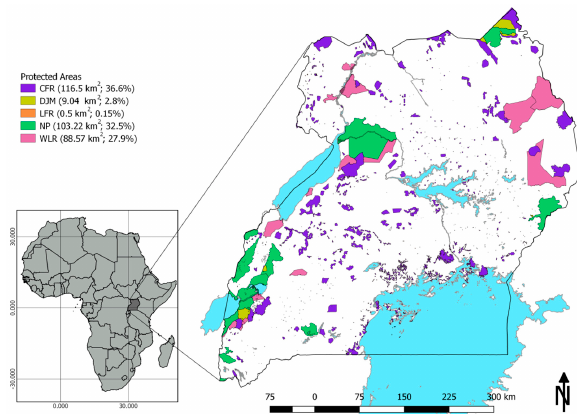
Figure 1. Location of Uganda in Africa, and protected areas (PAs) by management categories. The different colors (except the blue which are water bodies) represent management categories, namely: Central Forest Reserves (CFR), Dual Joint Management (DJM), Local Forest Reserves (LFR), National Parks (NP), and Wild Life Reserves (WLR). In parenthesis of the legend are the values of total area (km 2 ) and area as percentage of the total protected area (%).